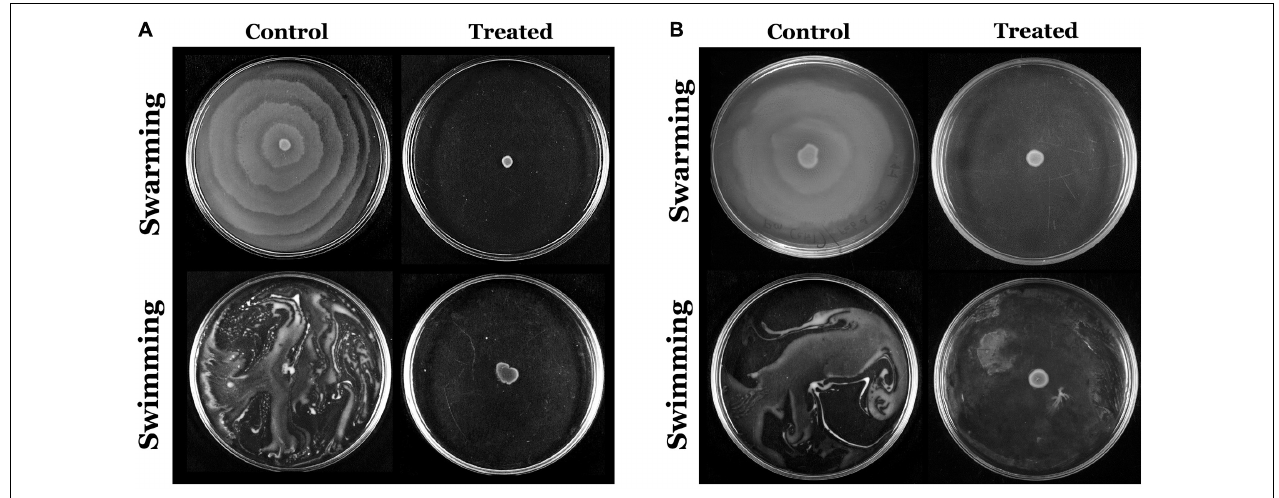
FIGURE 6 | Assessment of inhibitory efficacy of HMB (at its MBIC) on swarming and swimming motility of Proteus mirabilis (A) ATCC and (B) CI. HMB, 2-hydroxy-4-methoxybenzaldehyde; MBIC, minimum biofilm inhibitory concentration; ATCC, American Type Culture Collection; CI, clinical isolate.